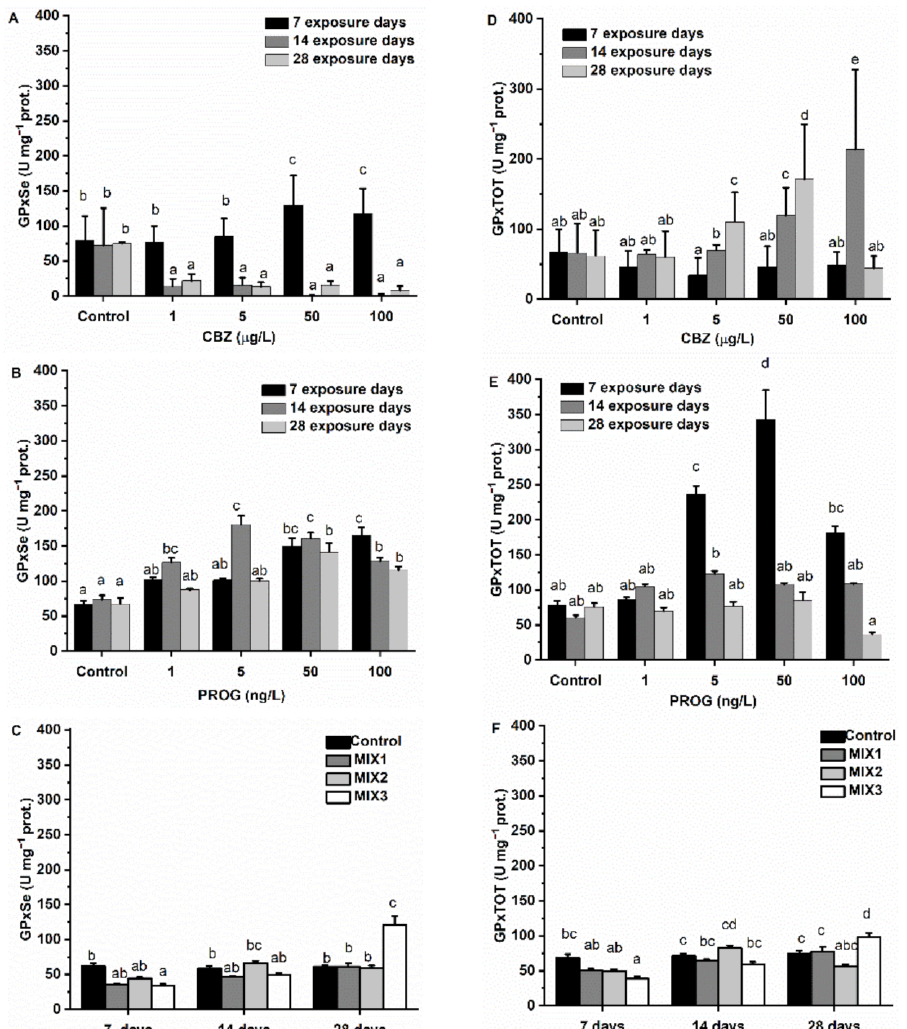
Figure 5. Changes of biotransformation enzymes’ activity—GPxSe ( A – C ) and GPxTOT ( D – F ) in the liver of Danio rerio exposed to ( A , D ) CBZ, ( B , E ) P4, and ( C , F ) binary mixtures of CBZ and P4 for 7, 14, and 28 days. Data are expressed as mean ± standard deviation of fifteen replicates ( n = 15). Different letters indicate significant differences at p < 0.05 after a two-way ANOVA followed by Tukey’s post hoc